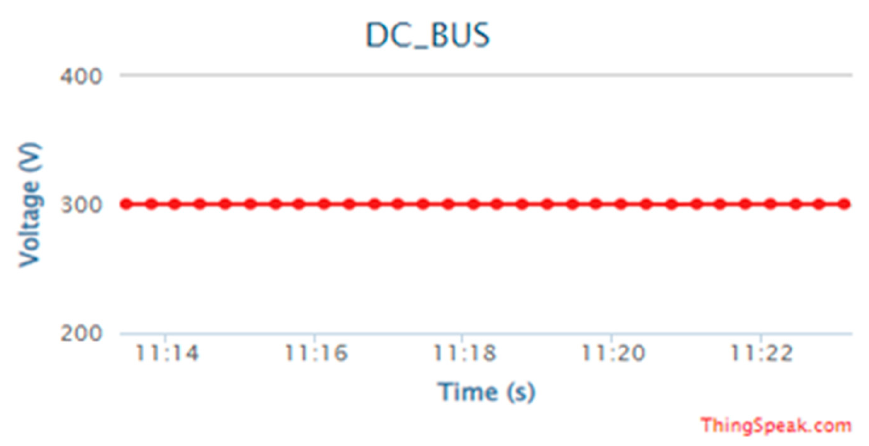
Figure 18. Variation in SOC.